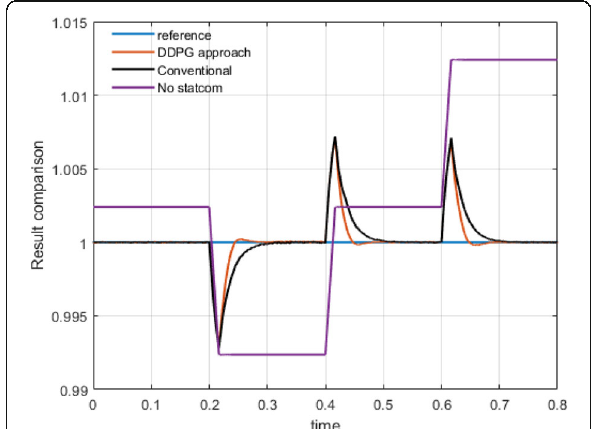
Fig. 4 (Abstract P5). Result comparison of voltage at bus